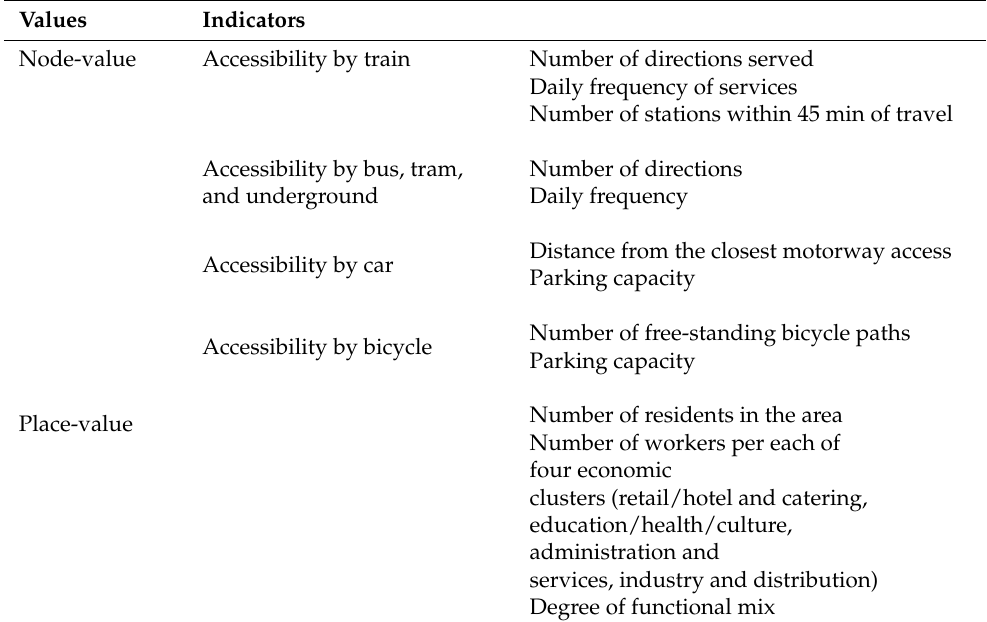
Table 1. Selection of indicators from previous literature